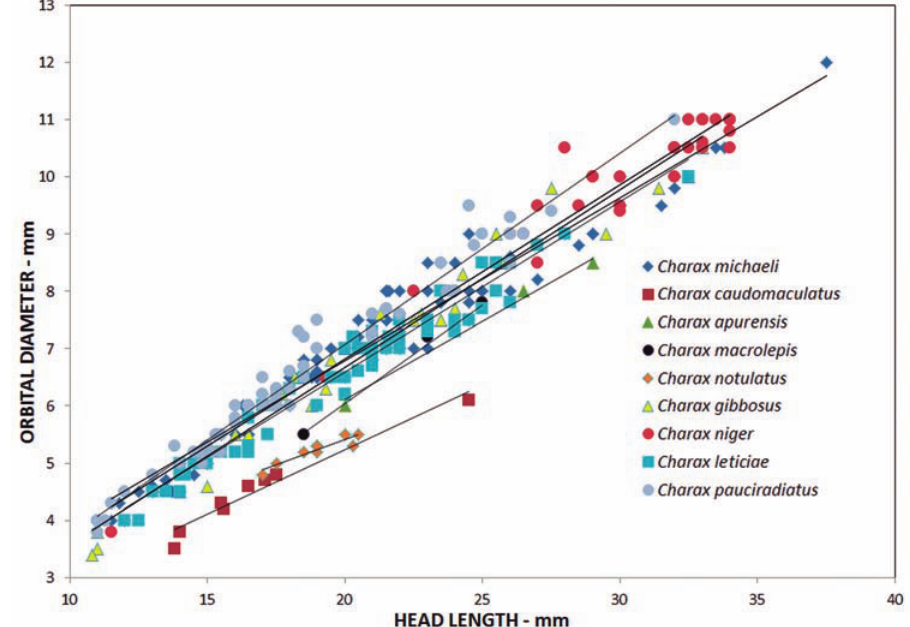
Fig. 4. Orbital diameter as a function of head length for species of Charax